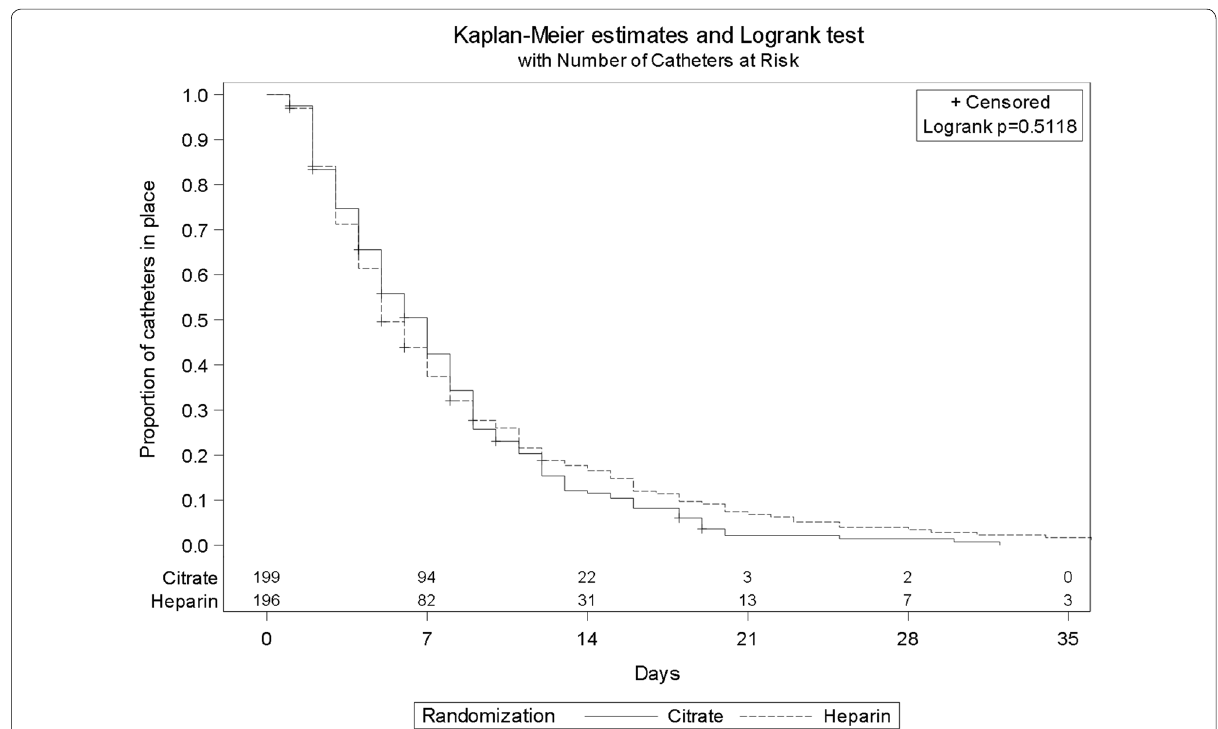
Fig. 2 Event‑free survival of the first non‑tunneled hemodialysis catheter in the citrate and heparin groups